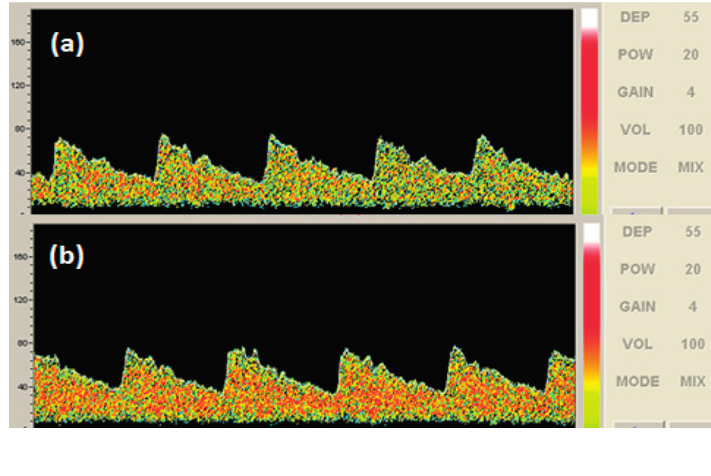
Figure 7. The Doppler sonographic measurement at 20% power: ( a ) commercial transducer; ( b ) PMN-PT single crystal based